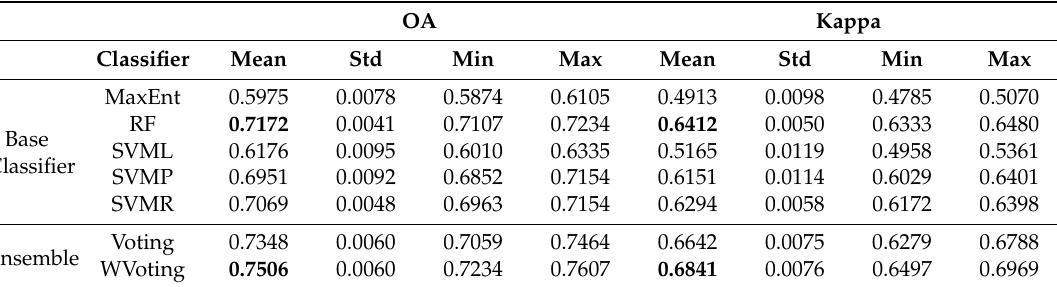
Table 5. Summary statistics for the overall accuracy and kappa coefficient of base classifiers and ensembles. Maximum Entropy Model (MaxEnt). Random Forest (RF). Support Vector Machine (SVM) with linear kernel (SVML). SVM with polynomial kernel (SVMP). SVM with Gaussian kernel (SVMR). Majority voting (Voting). Weighted majority voting (WVoting). In bold, the maximum OA (mean) and the maximum kappa (mean) for base classifiers and ensembles.